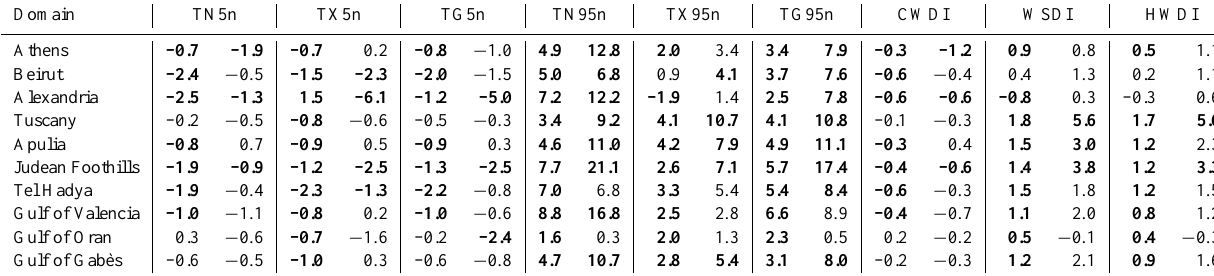
Table 6. Trends of indices of extremes, as in Table 4, but for summer (JJA).